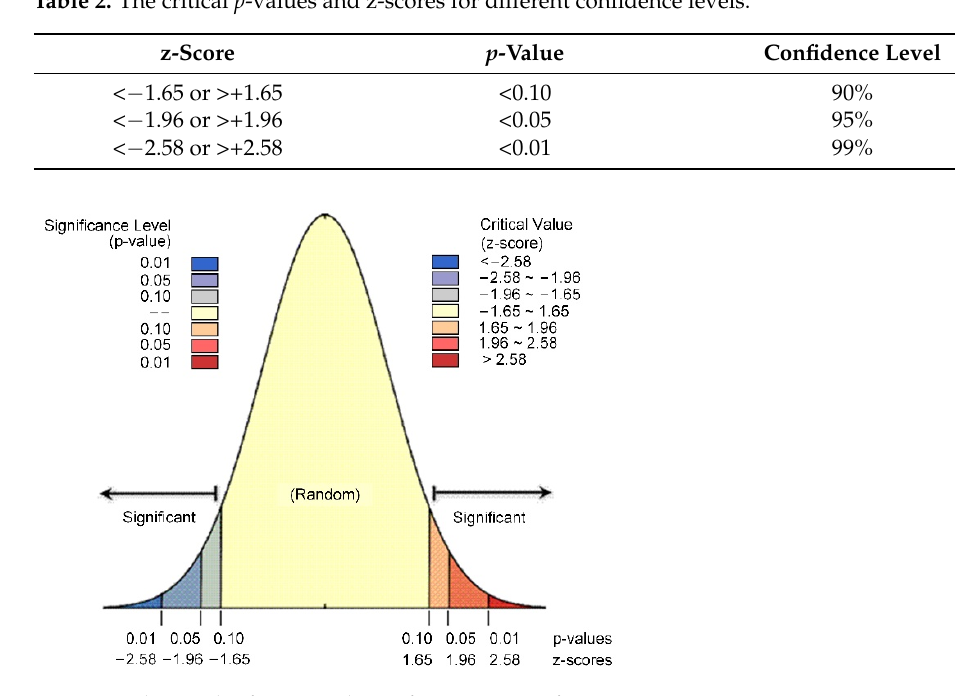
Figure 3. The result of statistical significance testing for Gi*.